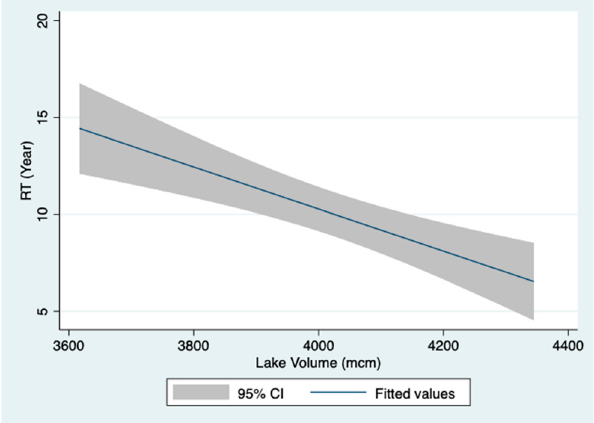
Figure 21. Linear regression (95% CI) between annual means (1970–2020) of Hydraulic residence time (HRT) (Years) and lake volume (mcm).